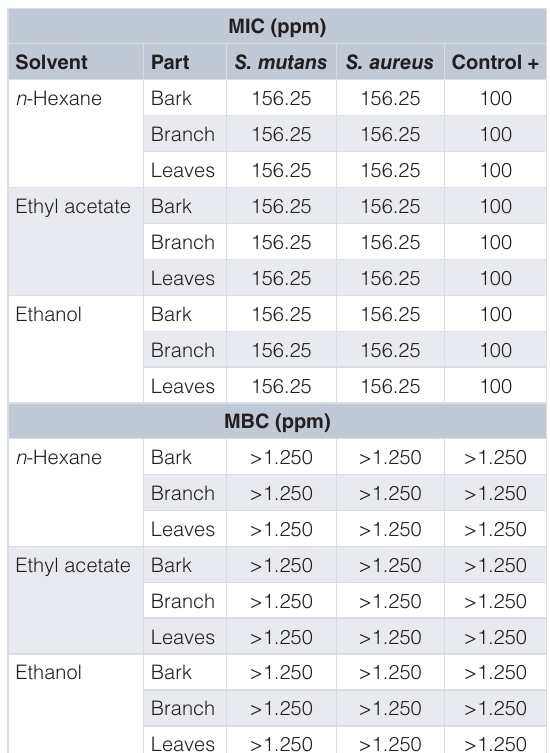
Table 3. Minimum inhibitory and bactericidal concentrations of the L. angulata